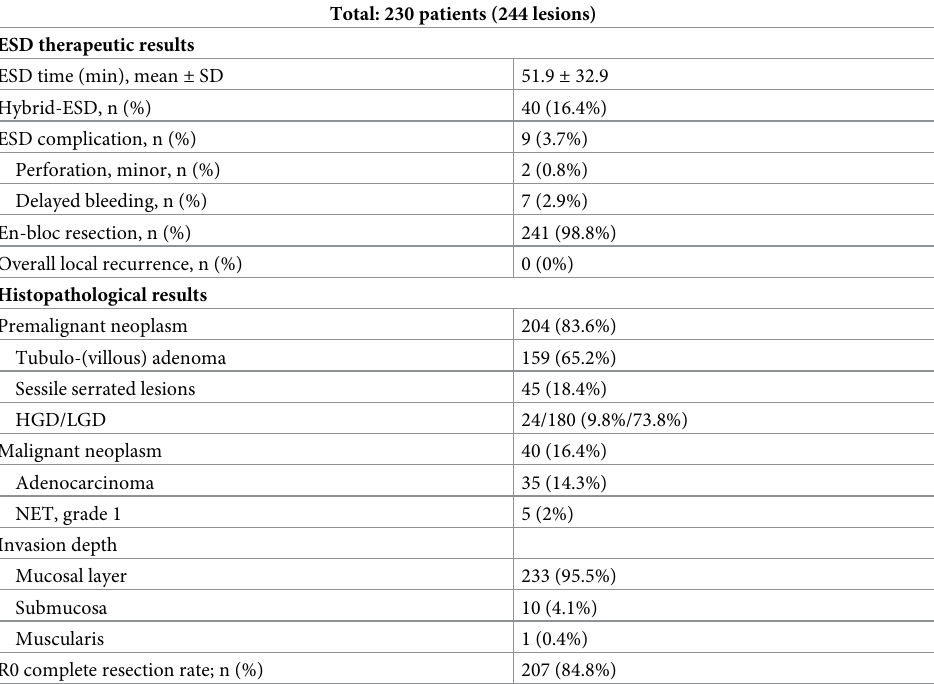
Table 2. Therapeutic and histopathological results of ESD for colorectal neoplasms.